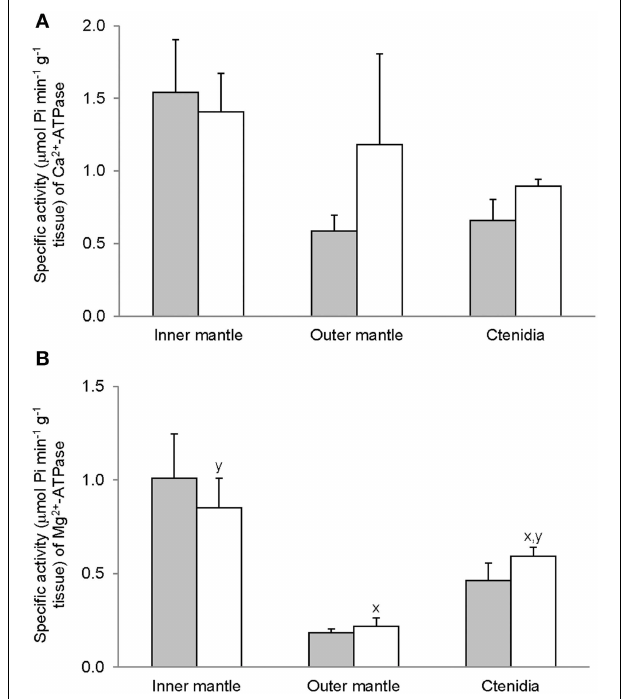
FIGURE 1 | Mass-specific activity ( µ mol Pi min − 1 g − 1 tissue) of (A) Mg 2 + -ATPase and (B) Ca 2 + -ATPase from the inner mantle, the outer mantle, and ctenidia of Tridacna squamosa exposed to 12h of darkness (control; closed bar) or 12h of light (open bar). Values represent means + S.E.M. ( N = 4 ). Means not sharing the same letter (x, y) are significantly different from each other ( P < 0 . 05